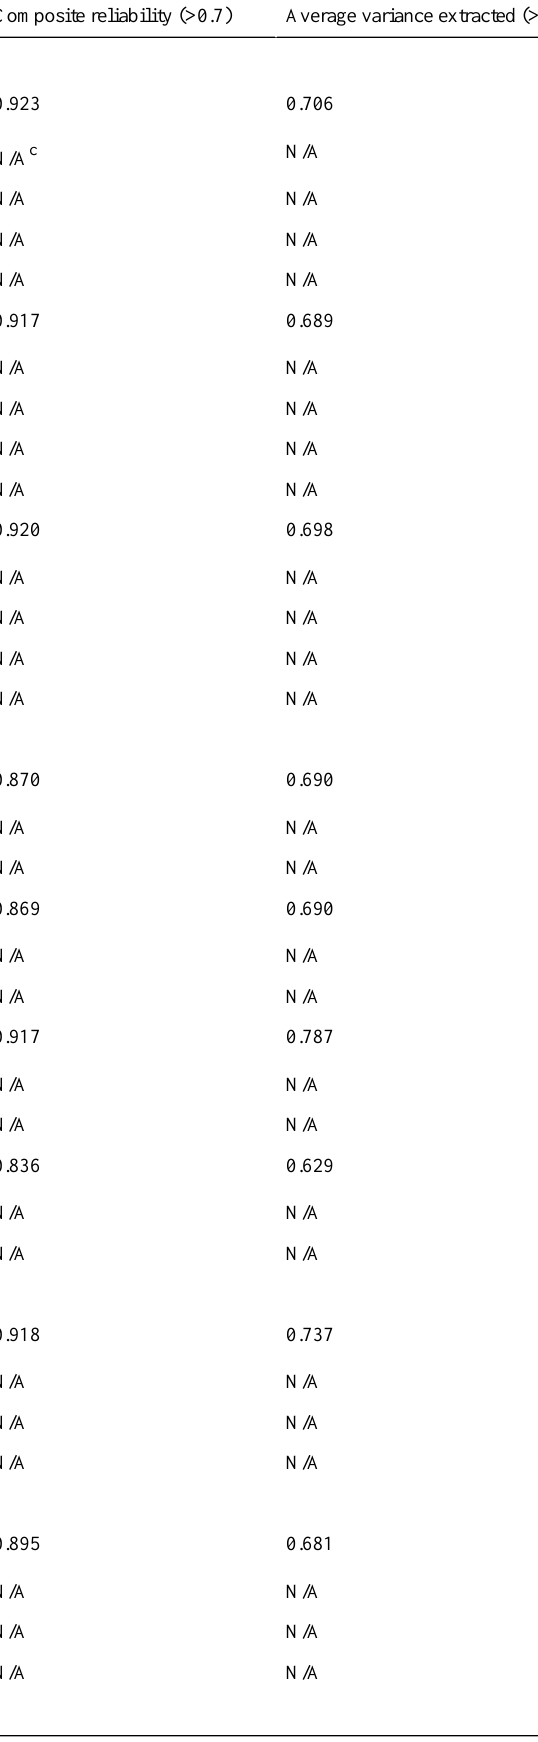
Table 3. Results of convergent